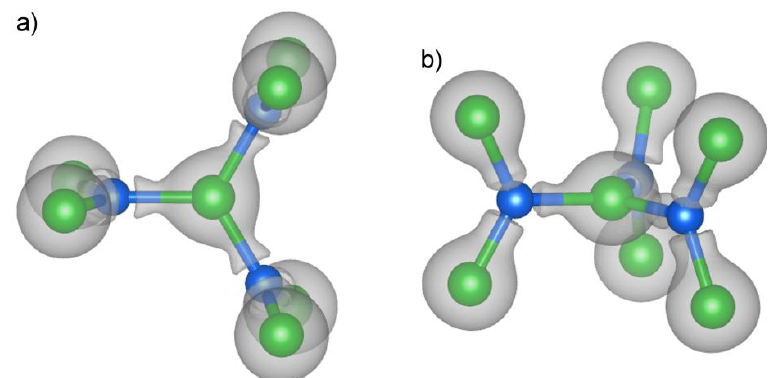
Figure 3. The valence electron density isosurface around the Pt both ( a ) perpendicular to c and ( b ) along c . The triangular distribution of peaks emanating from each Si atom is suggestive of sp 2 hybridization of the Si. Isosurface level: 0.4 electrons/Å 3